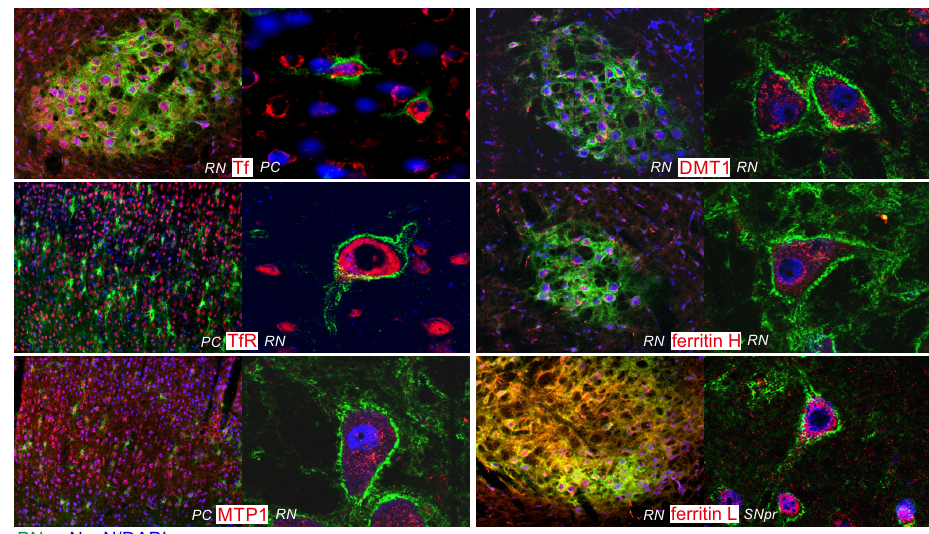
Figure 4. Immunohistochemistry. Brain slices were immunohistochemically stained for iron proteins (antibody, Cy3-labeled) and perineuronal nets (WFA, Cy2). Neurons (NeuN, Cy5), or in case of TfR nuclei of cells (DAPI), were counterstained. The representative images from parietal cortex (PC), red nucleus (RN) and substantia nigra pars reticulata (SNpr) show that all iron proteins can be visualized and are distinctly visible in the cytoplasm of the cells. Ferritin L, which is supposed to be more prominent in glial cells, is also well represented in neurons. A difference in iron protein content of PN + and PN – neurons cannot be distinguished by naked eye, but was revealed by quantification of the immunofluorescence signal intensity using SBC. Scale bar: